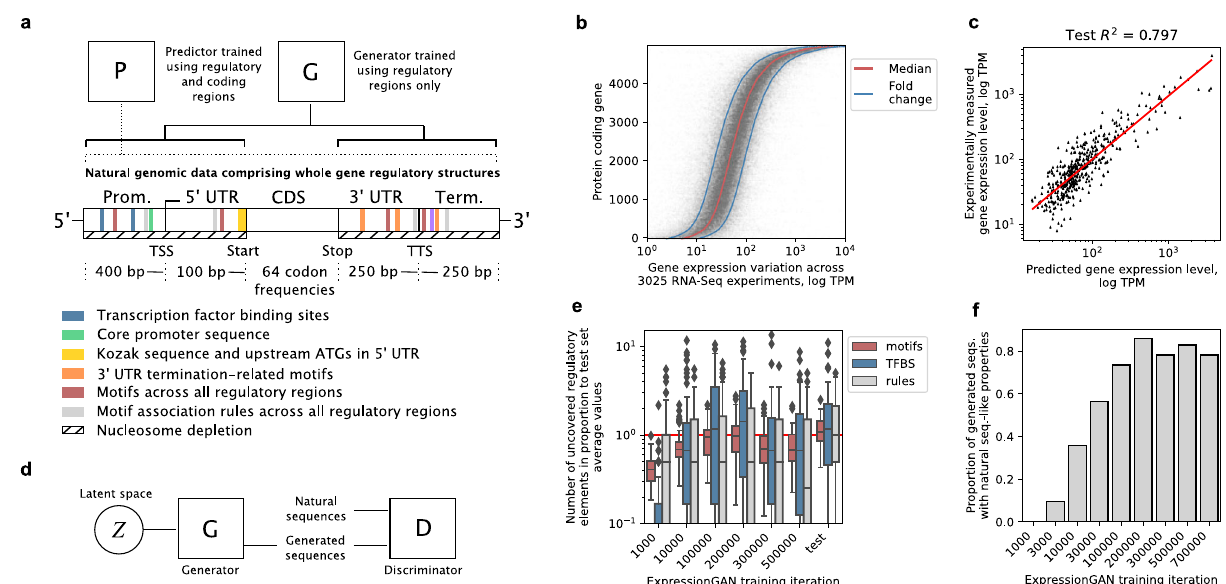
Fig. 1 | Implementing a generative strategy to design regulatory DNA. a Schematicdepictionofthe Saccharomycescerevisiae naturalgenomicsequencing datasetwasusedtotrainboththepredictive(P) 7 andgenerative(G)modelsusedin thestudy.Thedatasetspannedthewholegeneregulatorystructureof1000bpand included promoter, terminator, and untranslated regions (UTRs) as well as codon frequenciesofcodingregions.Thedifferentnaturalsequencepropertiesrelatedto DNA cis -regulatory grammar and further analyzed with the generator are indicted: transcription factor binding sites (TFBS, blue), core promoter elements (green), 5 ′ UTR elements (yellow), termination-related motifs (orange), deep learning- uncovered 7 motifs (red) and motifs association rules (gray), and nucleosome depletion (dashed lines) (see Supplementary Table 1 for a full list of tested seq. properties). b Medianexpressionlevelspergene(redline)derivedfrom3025RNA- Seq experiments 59 , with a 1-fold change marked in either direction (blue lines). c Performanceofthedeeppredictivemodelofgeneexpressiononthetestdataset